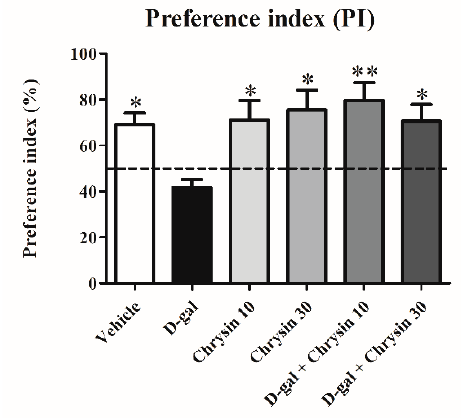
Figure 1. The exploration time (mean ± SEM) for each object in the NOL test after treatment. In the familiarization trial, no significant differences in exploration time between the objects in the two locations were found in any of the groups ( p > 0.05, A ). In the choice trial, the vehicle, chrysin 10, chrysin 30, and D-gal + chrysin groups explored the object in the novel location significantly longer than that in the familiar location (* p < 0.05, B ), but those in the D-gal group did not.